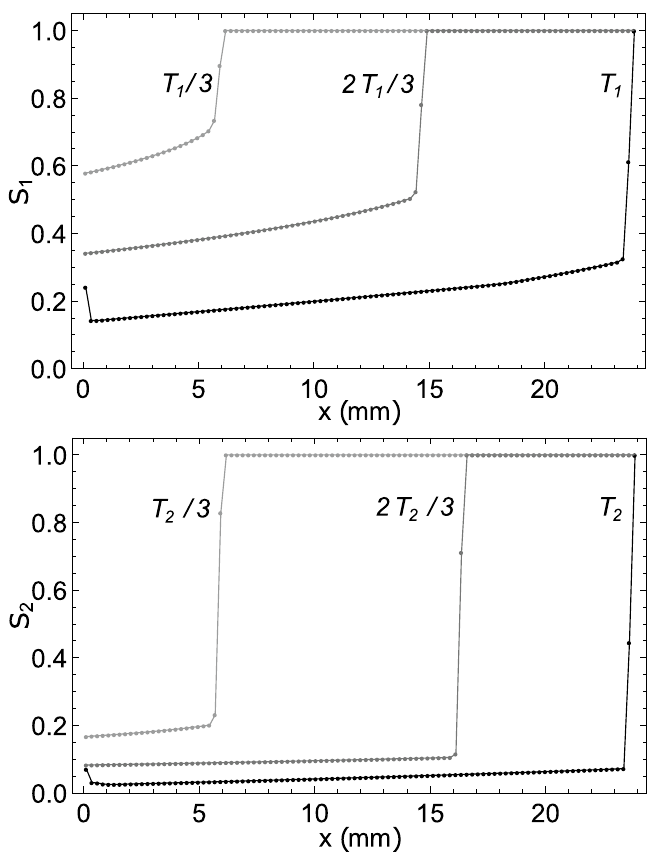
Figure 4. Blood concentrations S 1 ( t , x ) and S 2 ( t , x ) along the AVM for patient K in the optimal regime of two- stage